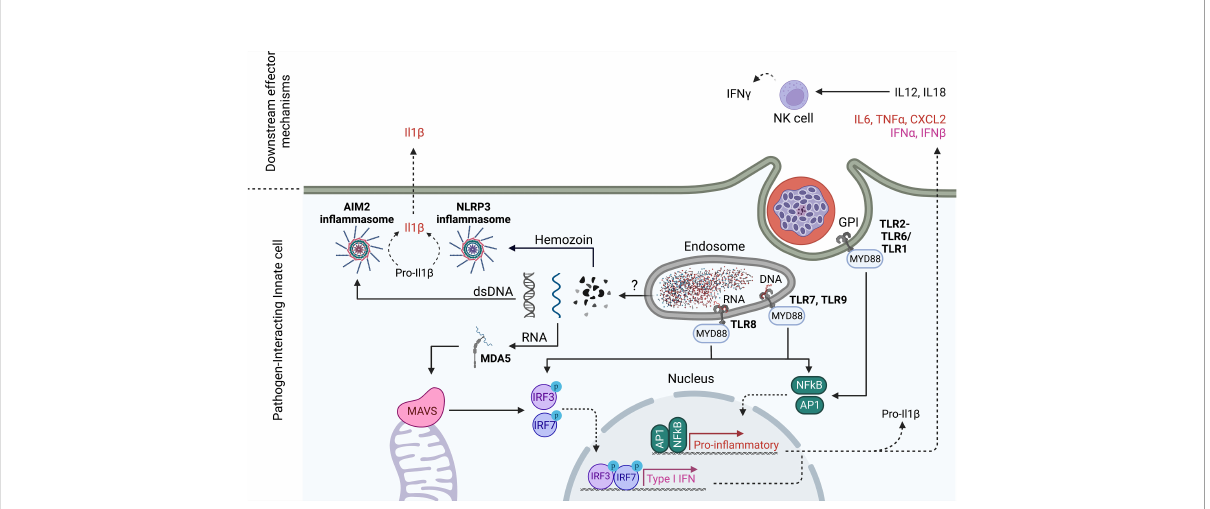
FIGURE 2 Innate sensing mechanisms of Plasmodium blood stages. TLR2 senses Plasmodium GPIs on the cell surface, while TLR7 and 9 recognize Plasmodium DNA in the endosome. In humans, TLR8 also senses degradation products of Plasmodium RNA. TLR engagement drives pro- in fl ammatory gene expression and a Type I IFN response (only TLR7, 8,9) that is dependent on MyD88 signaling. Plasmodium nucleic acids escape from the lysosome probably through direct association with hemozoin. In analogy to pre-erythrocytic stages, Plasmodium RNA in the cytoplasm is detected by MDA5 leading to MAVS activation and downstream Type I IFN gene expression. In addition, cytoplasmic double stranded (ds)DNA is sensed by AIM2 while Hemozoin is sensed by NLRP3, each leading to in fl ammasome assembly and enzymatic cleavage of pro-in fl ammatory mediators like Pro-IL1 b . Akin to pre-erythorcytic stages, NK cells have been shown to produce IFN g downstream of PRR recognition of parasite PAMPs. In ex vivo culture systems of human cells, NK cells have been shown to produce IFN g in response to innate cell produced IL18 and IL12 which were dependent on TLR8. Created with